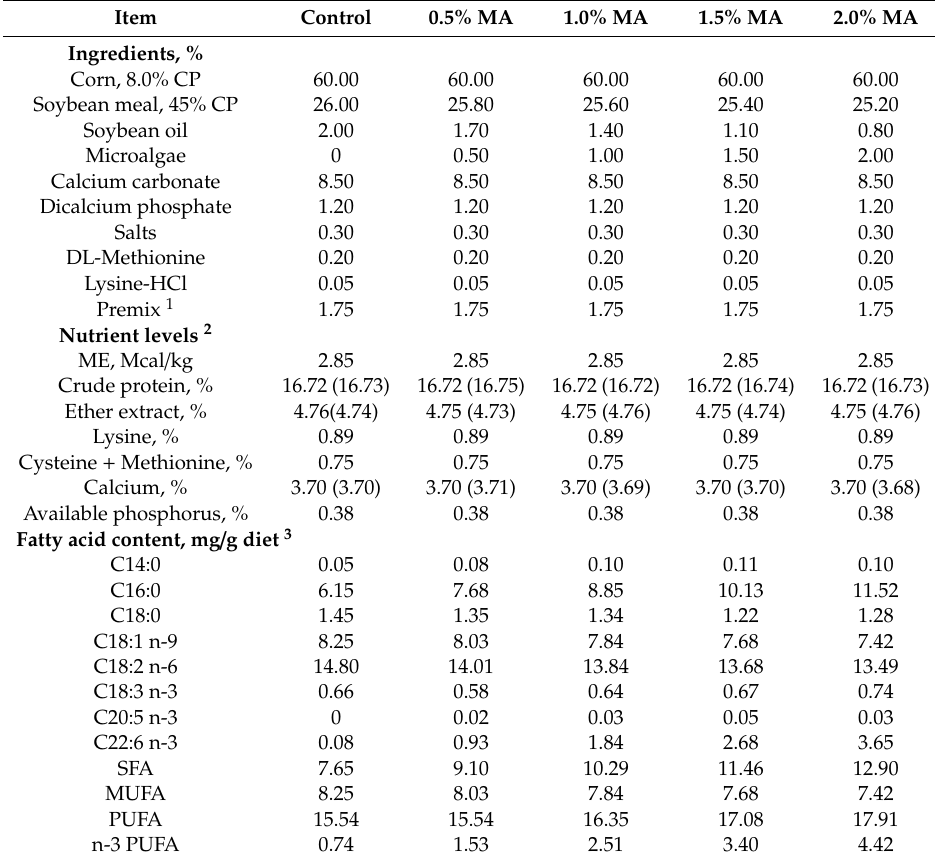
Table 2. Ingredients, nutrient levels, and fatty acid content of the experimental diets for laying hens (air-dry